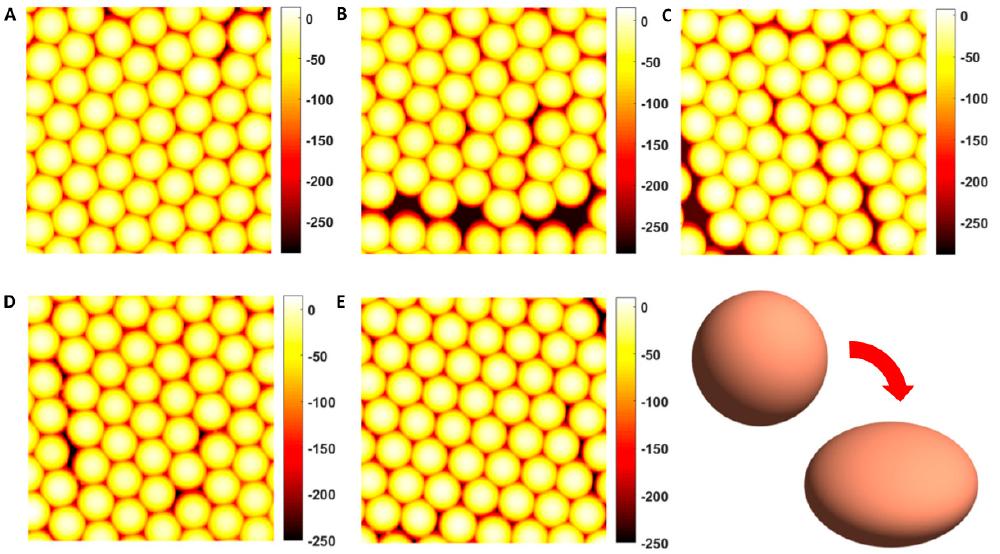
Figure 1. Examples of AFM micrographs for increasing ion fluence. The size of each micrograph is 2 µ m × 2 µ m. The fluence values for each of the plots correspond to those reported in Figure 2 (the di ff erent fluence values are indicated with letters A – E ). Sketch of the deformation of a sphere into an oblate ellipsoid.